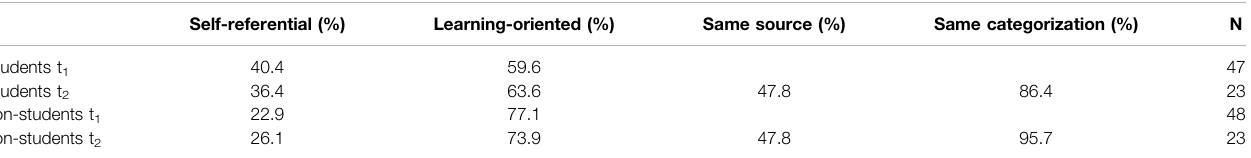
TABLE 6 | Metaphors of students and professionals at t 1 and t 2